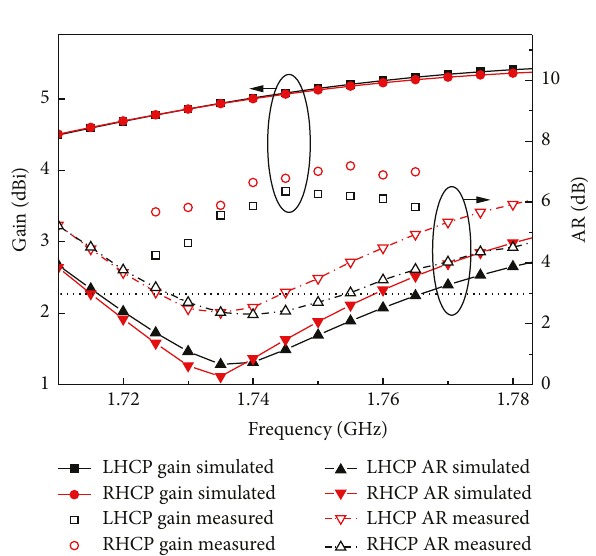
Figure 8: Simulated and measured AR and